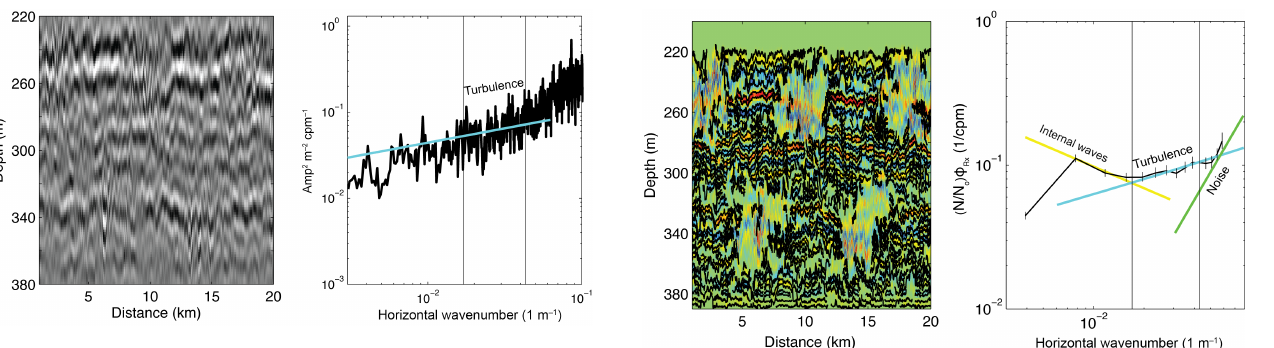
Figure 12. Synthetic seismic section overlaid with tracked reflec- tions and displacement spectra with 95% bootstrap confidence in- tervals (vertical bars). Displacement spectra match the character- istic slope of turbulence (cyan line) across horizontal wavenumbers 0.017–0.043cpm. Areas where we introduced turbulence are clearly seen as they contain few tracked reflections highlighting the diffi- culty in using displacement spectra to estimate turbulent energy in seismic data. Characteristic slopes of internal waves (GM77) and noise (KM07b) are shown in yellow and